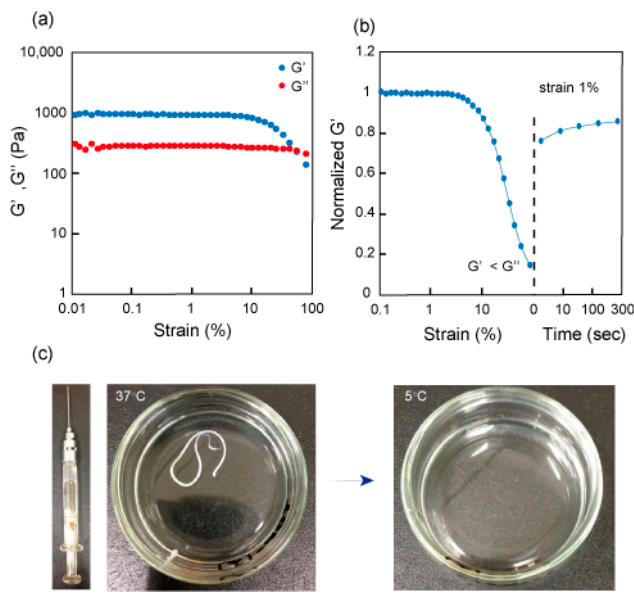
Figure 5. Rheology analyses of the self-healing process and injectable capability of the poly(NAAMe 53 - b -NAGMe 240 - b -NAAMe 53 ) hydrogel. ( a ) Storage modulus (G’) and loss modulus (G”) on strain sweep. ( b ) Recovery of stiffness after failure incuced by shear strain. ( c ) Pictures taken when the poly(NAAMe 53 - b -NAGMe 240 - b -NAAMe 53 ) hydrogel (30 wt %) was injected by using a syringe (left) into water at 37 °C (middle) and when cooled to 5 °C after one week-incubation at 37 °C (right).